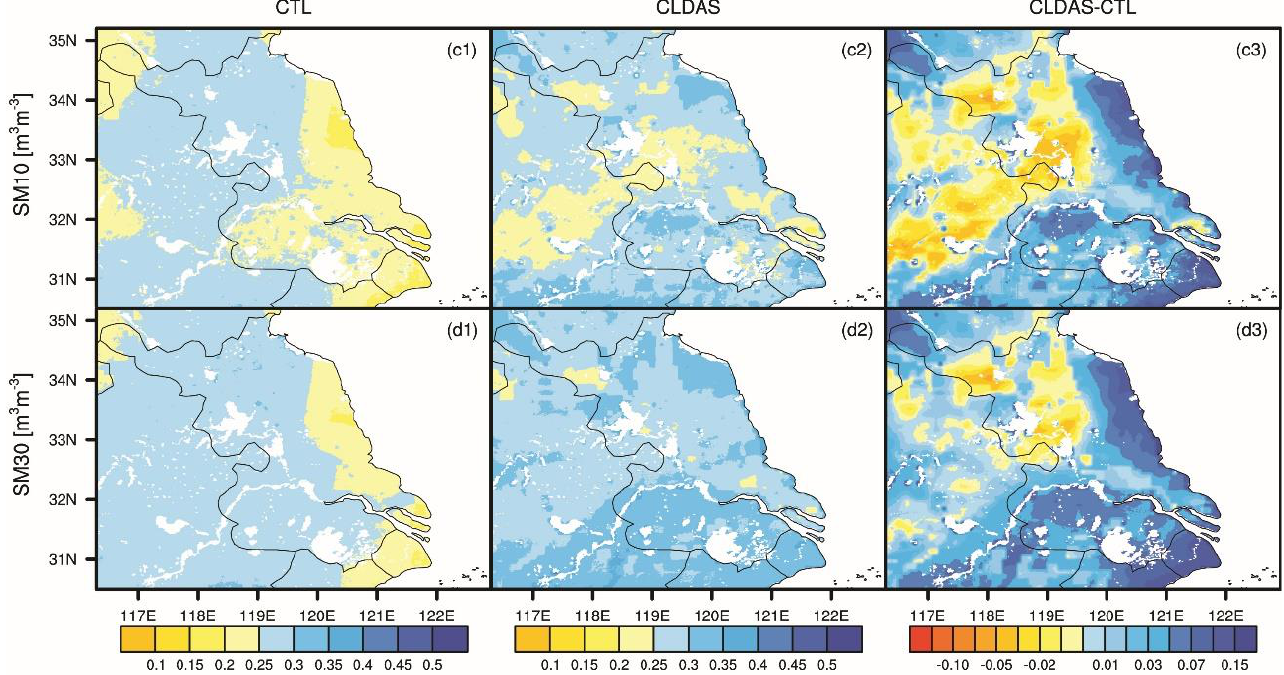
Figure 3. Spatial-distribution characteristics and relative differences over research period in EC. ( a1 , a2 , a3 ) Albedo and relative difference between WRF and MODIS data; ( b1 , b2 , b3 ) LAI and relative difference between WRF and MODIS data; ( c1 , c2 , c3 ) 10 cm soil water and relative difference between WRF and CLDAS data (unit: m 3 m − 3 ) and ( d1 , d2 , d3 ) 30 cm soil water and relative difference between WRF and CLDAS data (unit: m 3 m − 3 ).